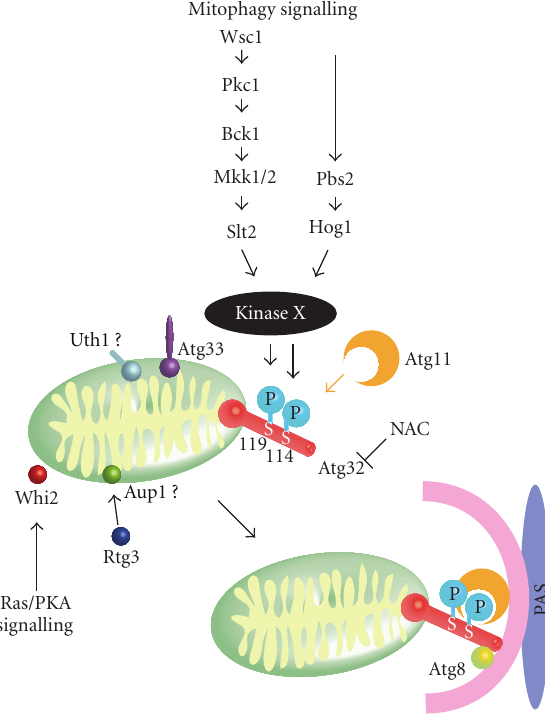
Figure 1: Mitophagy in yeast. Environmental or intracellular fac- tors trigger the mitophagy-signaling pathways that include two MAPKs (Slt2 and Hog1), finally reaching and activating an uniden- tified kinase X. This kinase phosphorylates Ser114 and Ser119 on Atg32. Phosphorylation of Atg32, particularly at Ser114, mediates the Atg11–Atg32 interaction. Atg11 recruits mitochondria to the phagophore assembly site (PAS) where the autophagosome is gene- rated to enclose the mitochondria. The antioxidant compound N- acetylcysteine (NAC) inhibits mitophagy, presumably by suppress- ing Atg32 expression. The Atg32–Atg8 interaction increases the e ffi - ciency of mitochondrial sequestration by the isolation membrane. Atg33, Whi2, Uth1, and Aup1 have been reported to be required for mitophagy. However, the function of these proteins in mitophagy has not been